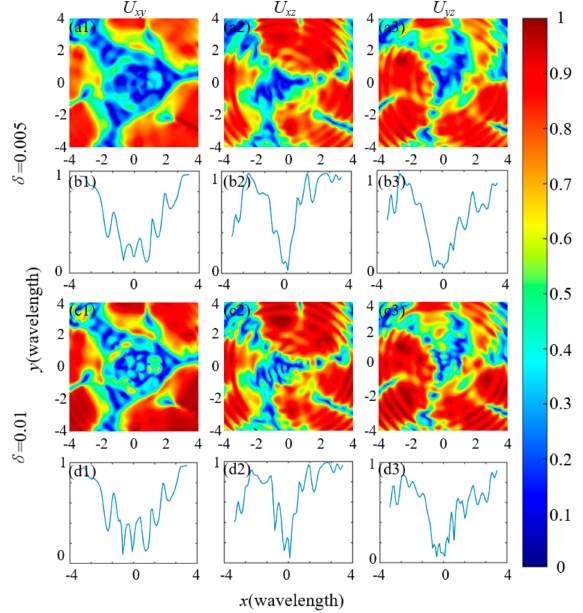
Figure 8. The degree of coherence between every component with different spatial coherence lengths δ . ( l = 3, p = 1, p ’ = 1, and n = 4). Where, ( a1 – d1 ) the component U xy , ( a2 – d2 ) the component U xz , ( a3 – d3 ) the component U yz .